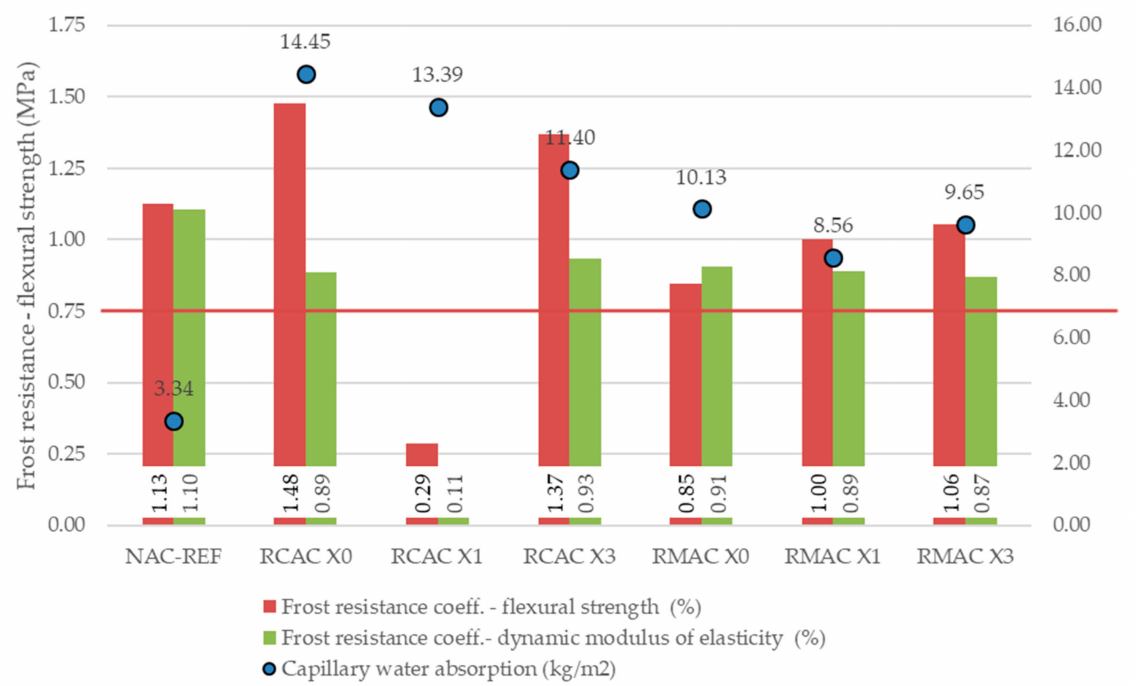
Figure 6. Frost resistance coefficient determined from the dynamic modulus of elasticity and flexu- ral strength.